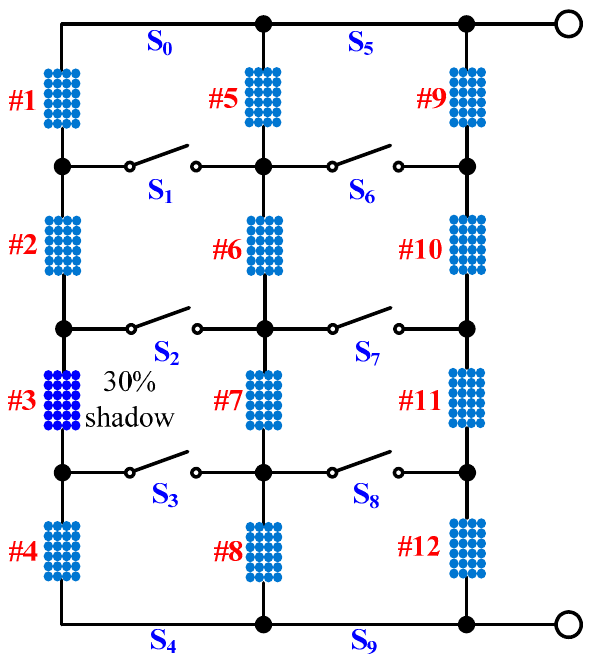
Figure 9. A pre-optimized array configuration with a 30% shadow in module 3.